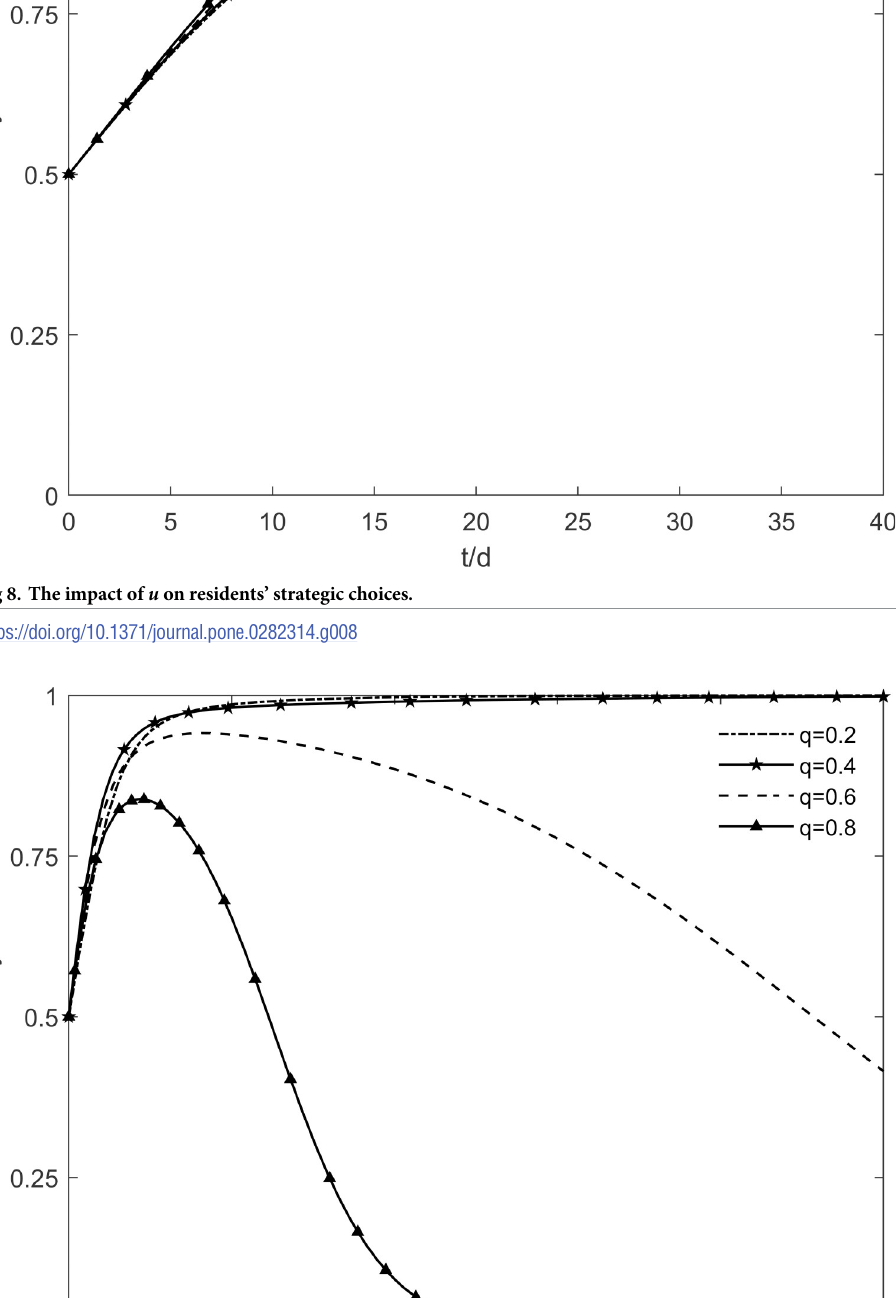
PLOS ONE | https://doi.org/10.1371/journal.pone.0282314 March 16,